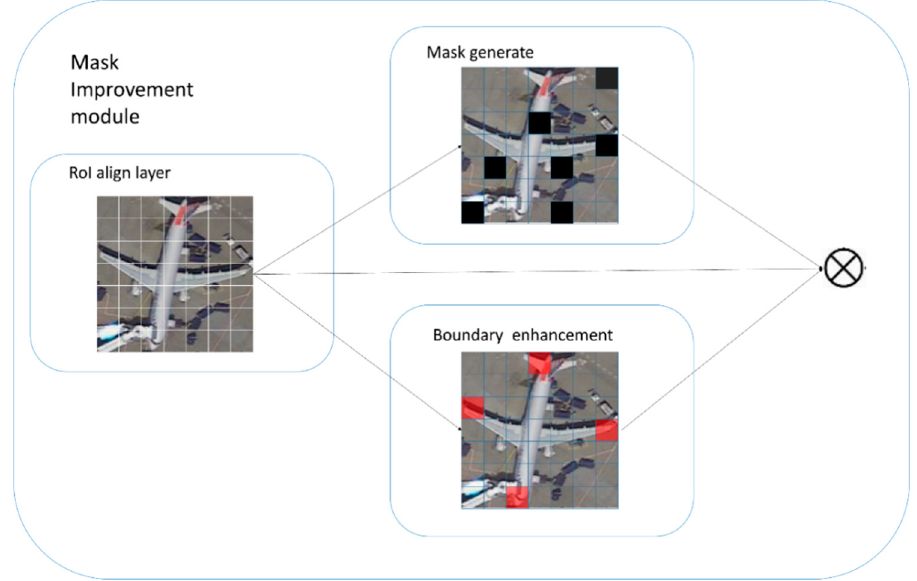
Figure 6. Mask improvement module takes image patches with the features extracted as input using the ROI align layer then blocks the position generated by the mask and enhances the image using boundary features.